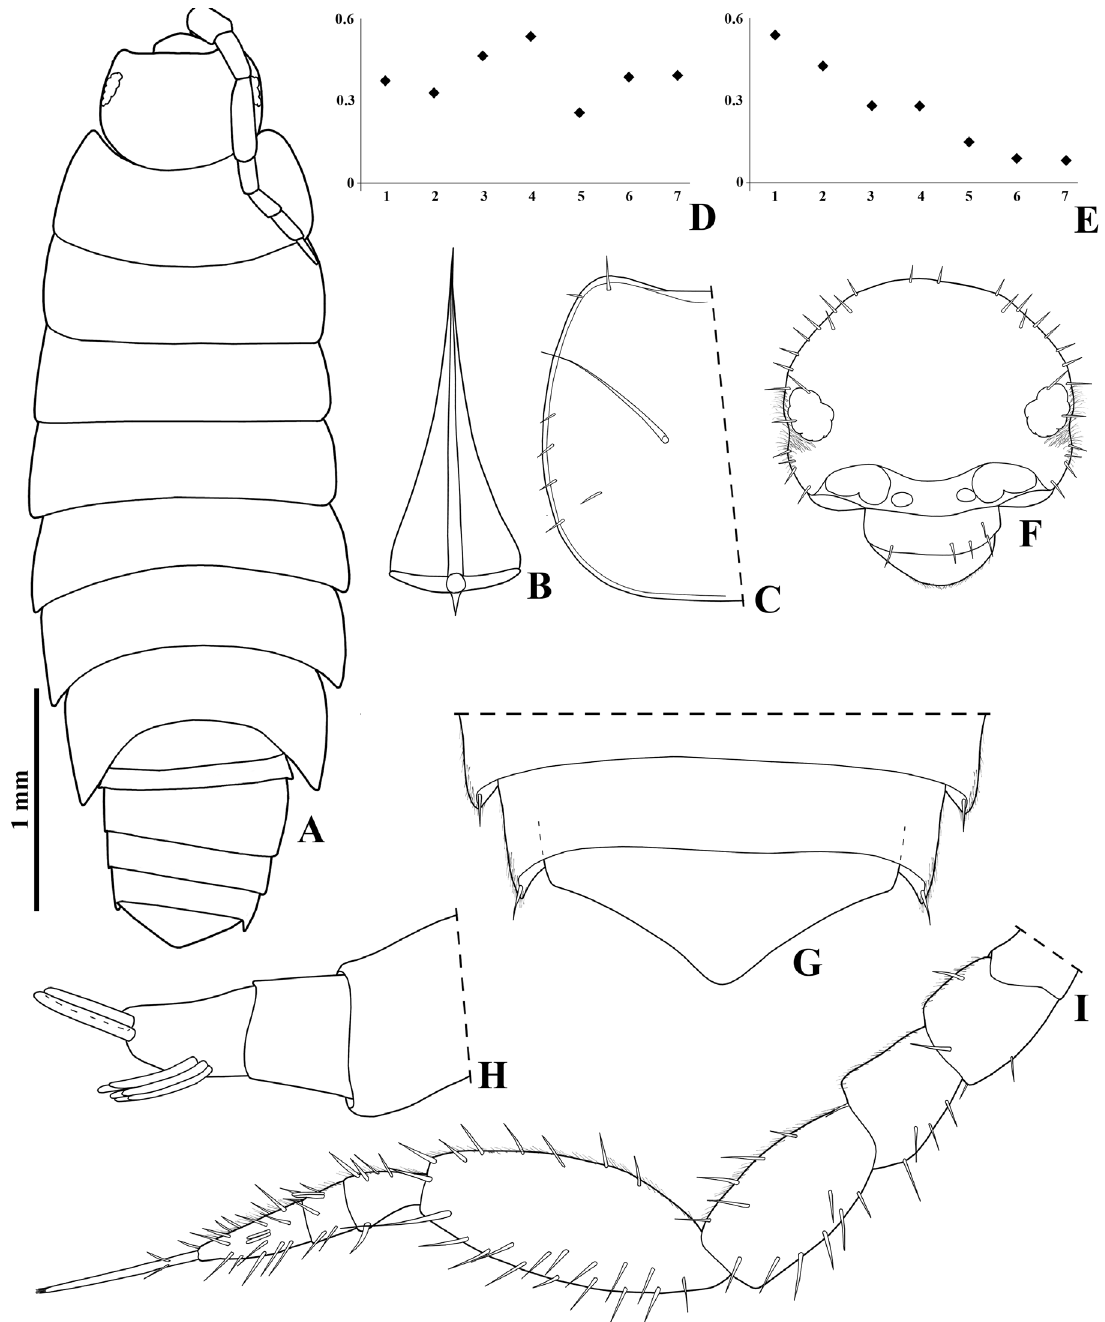
Fig. 5. Androdeloscia akuanduba Campos-Filho, Cardoso & Taiti sp. nov., ♀, paratype (MZUSP 39671). A . Habitus, dorsal view. B . Dorsal scale-seta. C . Pereonite 1 epimeron, dorsal view. D . Noduli laterales d/c coordinates. E . Noduli laterales b/c coordinates. F . Cephalon, frontal view. G . Pleonites 4–5 and telson. H . Antennula. I .